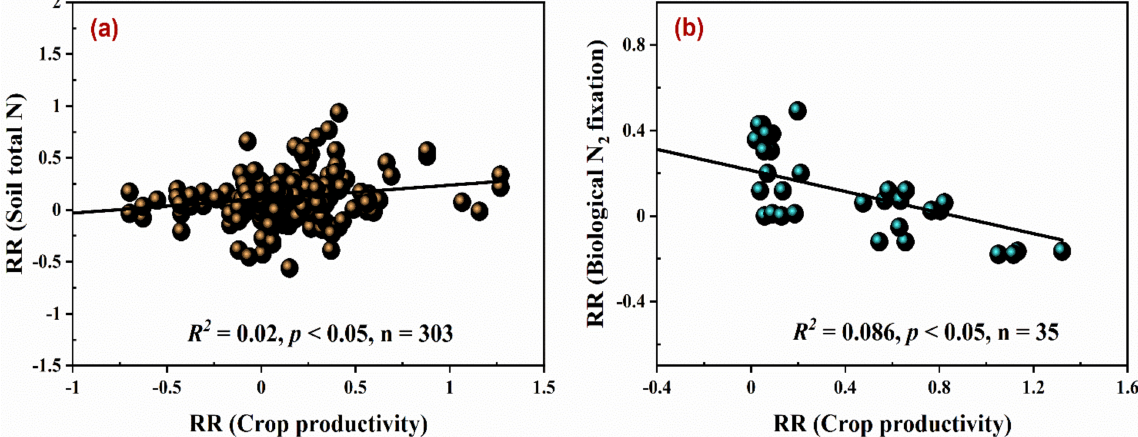
Figure 4. Relationships between the response ratios of crop productivity vs. ( a ) soil total N and ( b ) biological N 2 fixation under